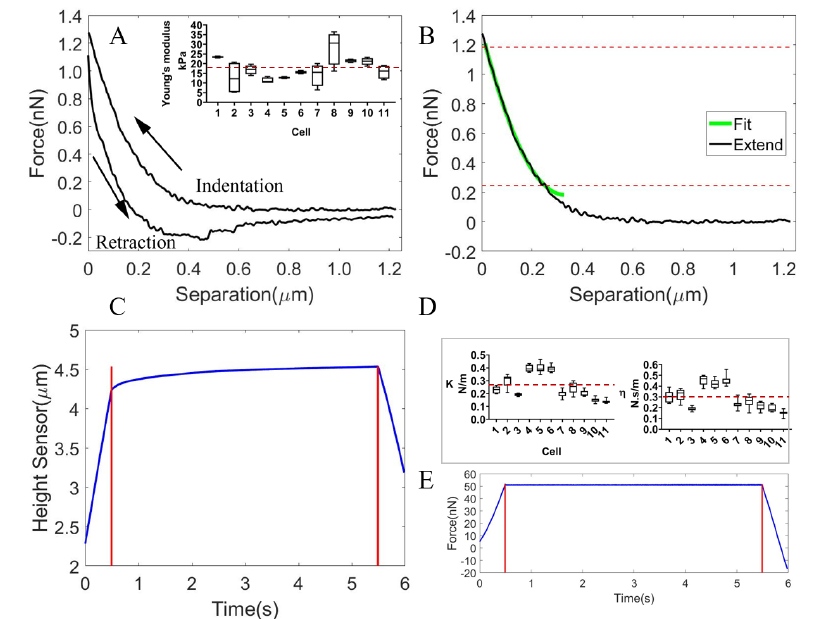
Figure 5. The response of the whole cell obtained by indenting the ZP surface using AFM for the development of the homogeneous model. ( A ) The force-indentation curve (indentation and retraction processes). The included figure shows the estimated Young’s Modulus of multiple cells. The average value is indicated with the red dotted line. ( B ) The fitting of the indentation (extending process) curve using the Sneddon model (focusing on the portion with a large slope between the two red horizontal lines). ( C ) The viscoelastic creep curve obtained by holding the indenting force at nearly 50 nN for 5 s shown in ( E ). ( D ) The k and η values of the Kelvin–Voigt model that was used to describe the viscoelastic creep behavior of the